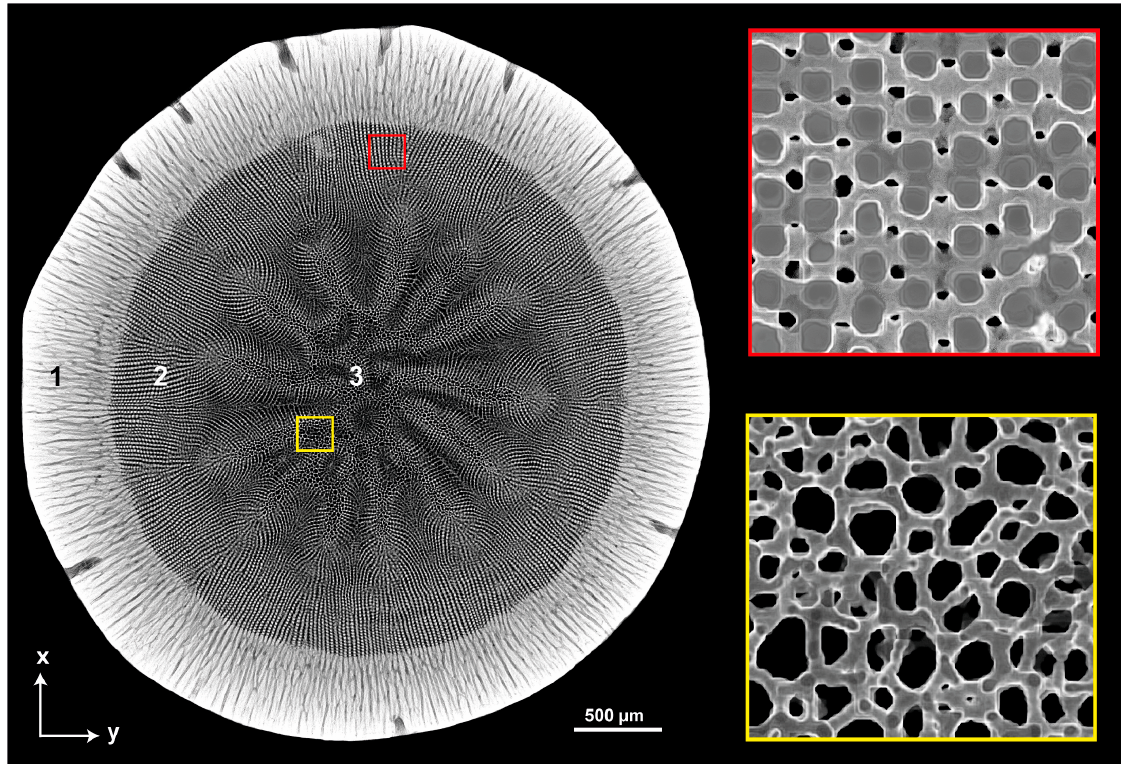
Figure 1. Cross sectional image of the aboral spine of Phyllacanthus imperialis based on µCT data visualizing the core–shell structure with its differentiated substructures. 1: Cortex, 2: Radiating layer, 3: Medulla.